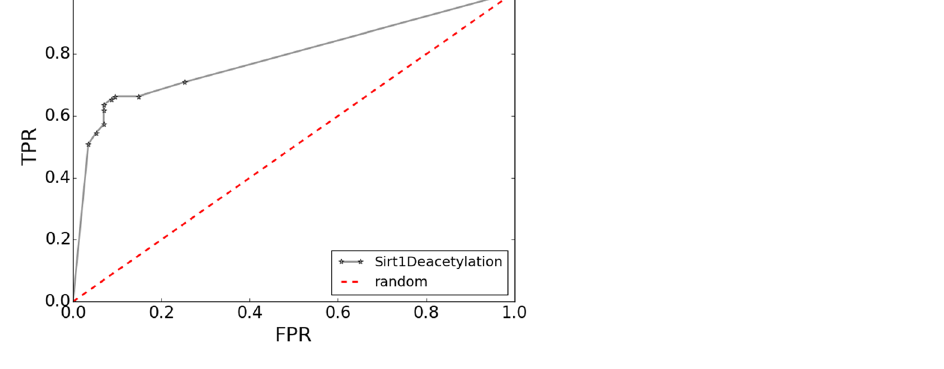
As shown in Fig. 3, compared with the prediction performance with only sequences, integrating all func- tional features increased the MCC from 0.10 to 0.65. The Sn and Sp of integrating all features were 0.71 and 0.92 (Table 2). Furthermore, from the prediction performance of integrating sequence features with different kinds of functional features, it is obvious that most of the functional features contribute to the improvement of the predic- tion performance except those from the Pfam database. Compared with sequence features alone, integrating the PPI information increased MCC from 0.10 to 0.58 (Fig. 3). BP, CC, and MF annotations brought improvement of MCC to 0.40, 0.48 and 0.46 respectively (Fig. 3). These results indicated that integration of functional features can greatly improve the prediction performance.